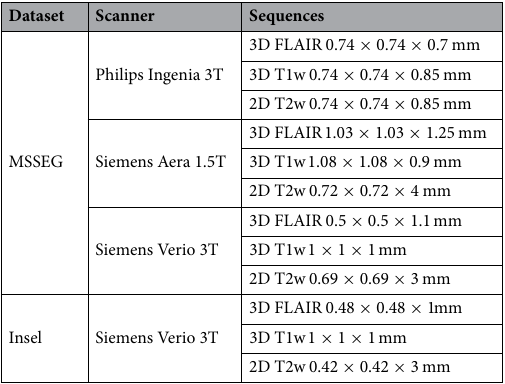
Table 1. Scanner and sequence details for the two datasets used in this